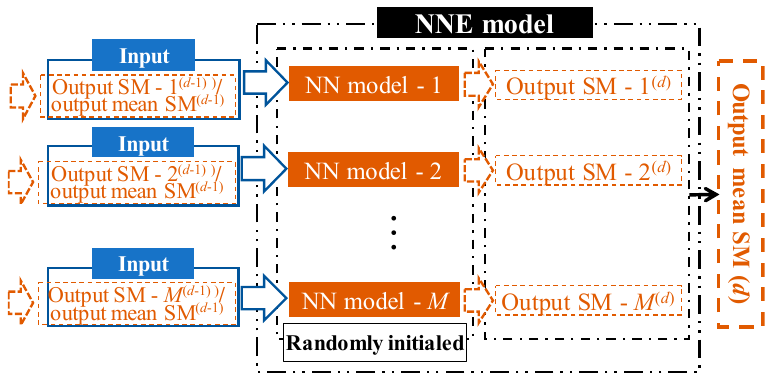
Figure 2. Diagram of the neural network ensemble (NNE) model. SM: soil moisture; M is the number of ensembled neural network (NN) models; d indicates the current day on which the NNE model is predicting.